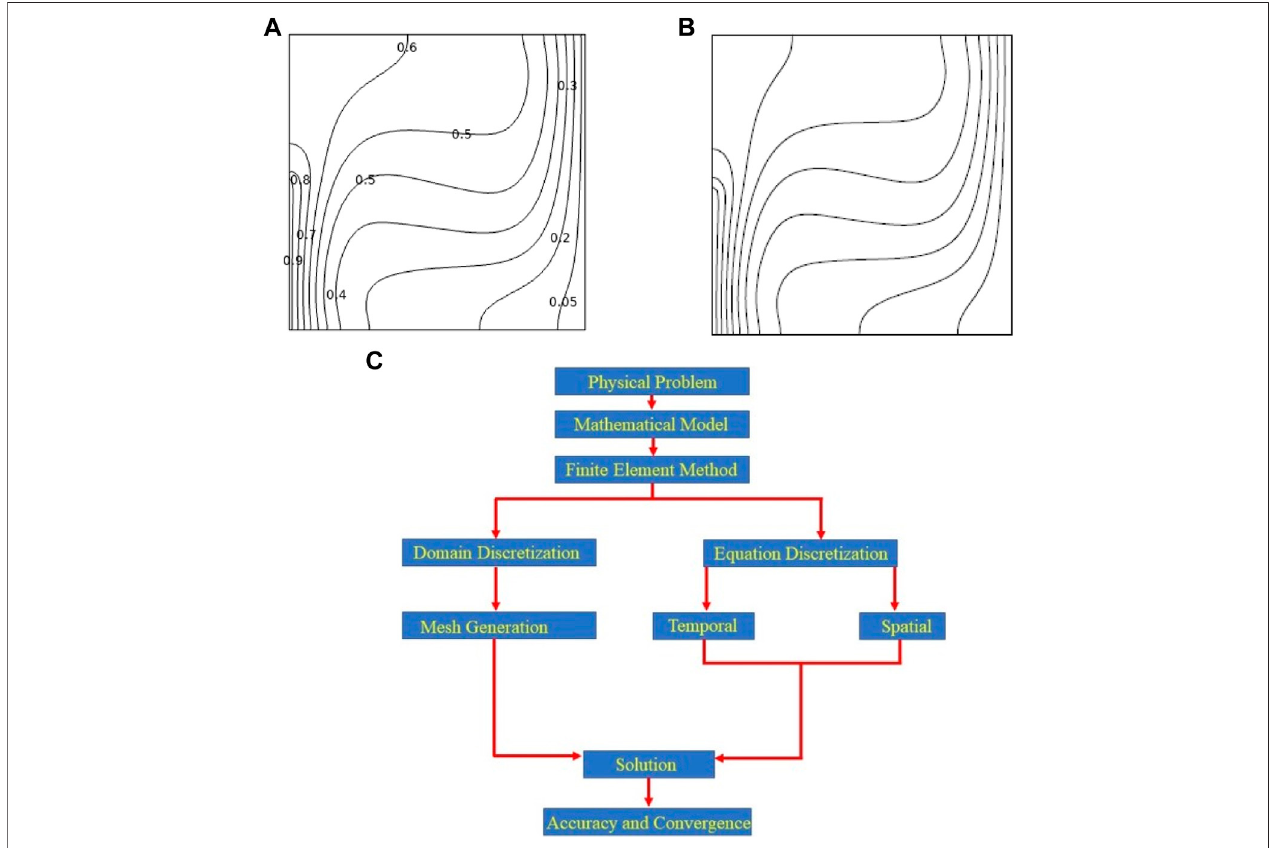
FIGURE 2 | Isotherm comparison: (A) present work, (B) H.F. Oztop, E. Abu-Nada [28]. Panel (C) : Flow chart of working rule.